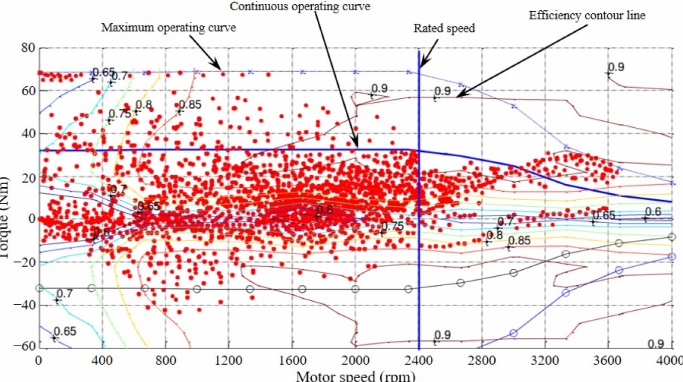
Figure 9. Distribution of the FSPM motor operating conditions.